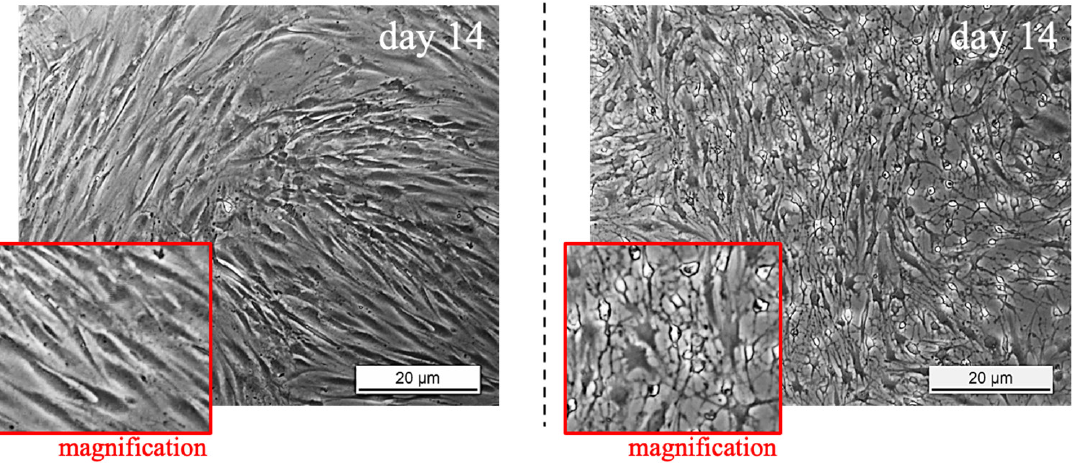
Figure 3. Brightfield and immunofluorescence images illustrating the shape of tendon stem/progenitor cells (TSPCs). Cells extracted from healthy tendons showed specific alignment and elongated shape modification (fibroblast-like), whereas cells obtained from pathological tendons exhibited a large perinuclear area with thin dendrites (zoomed area: 150%). β-actin staining (red) was used to display cells cytoskeleton. Scale bar: 20 μm.